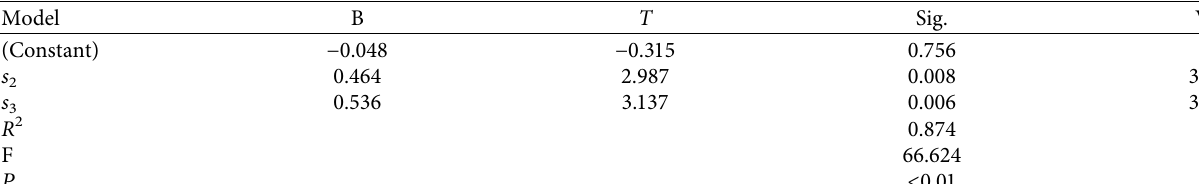
Table 3: The relevant coefficient test results.